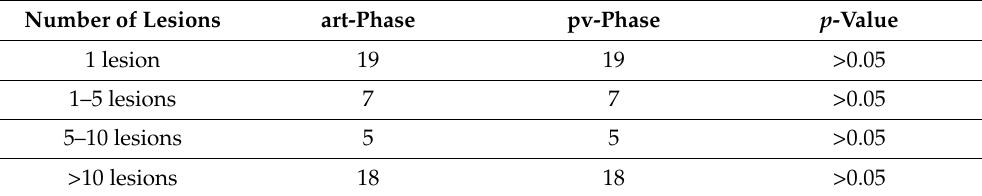
Table 2. The number of delineable lesions in the arterial and portal venous contrast phases, sorted by number.